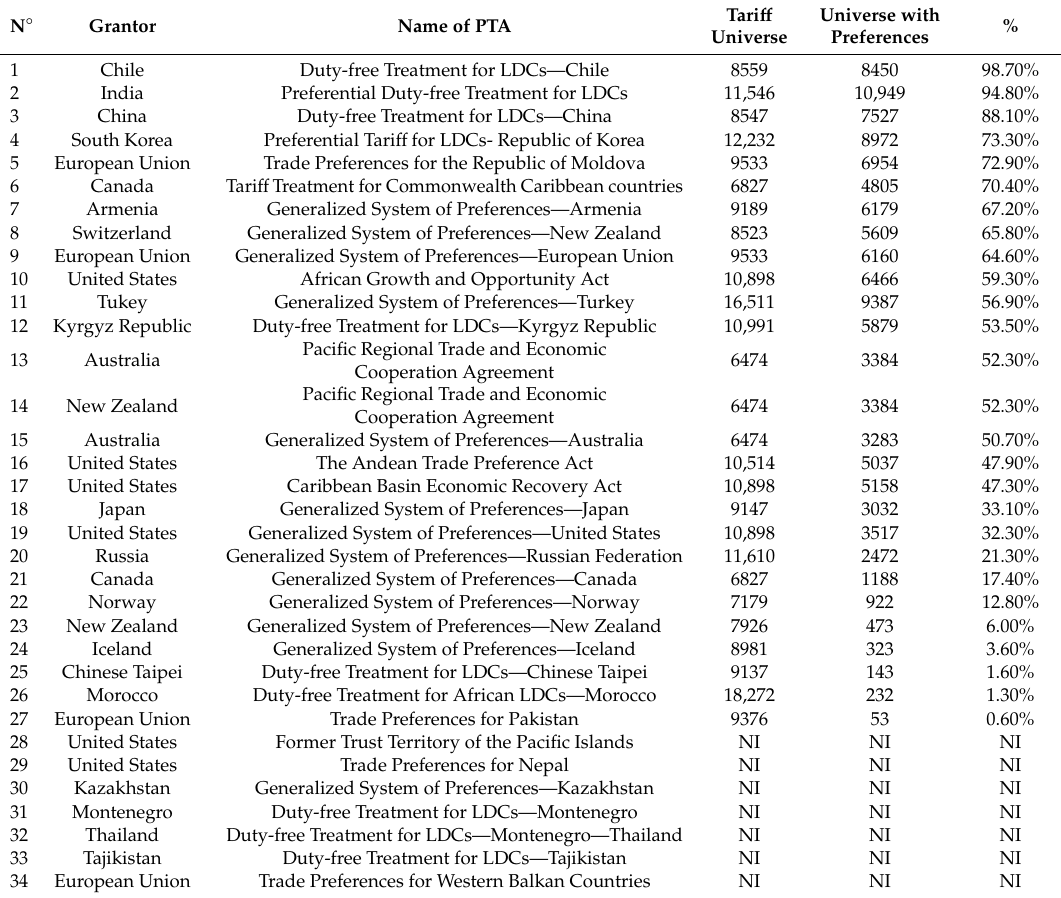
Table 4. List of PTAs by the preferences from